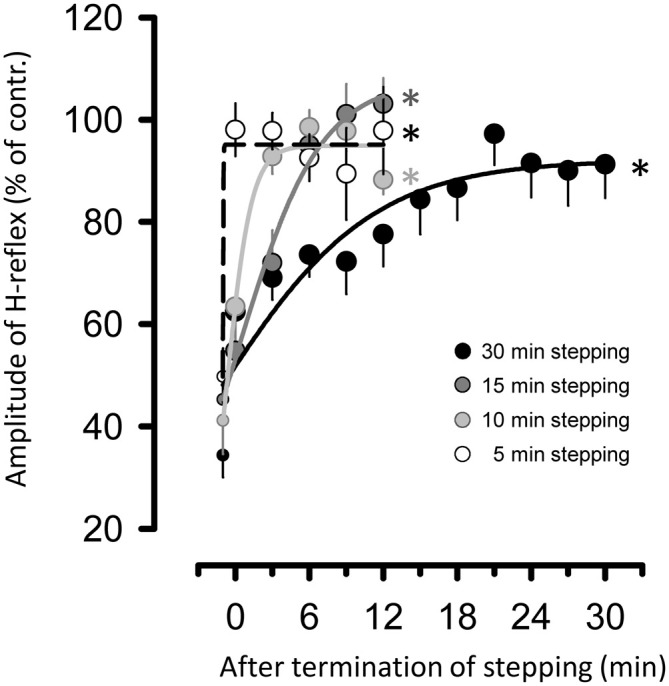
Relationship between duration of passive DGO stepping [5- (opened circles), 10- (light gray circles), 15- (dark gray circles), and 30-min (filled circles) stepping tasks] and changes in amount of suppression of the H-reflex for up to 30 min after the termination of stepping. To apply the curve-fitting analysis, data for suppression of H-reflex during stepping (i.e., last session of stepping in each task) were also used (small circles in each stepping task). The data were fitted with a three-parameter sigmoid function variation of the logistic equation using the Levenbrerg-Marquard nonlinear least-mean-square algorithm. All curve fits are significant. *p < 0.001.